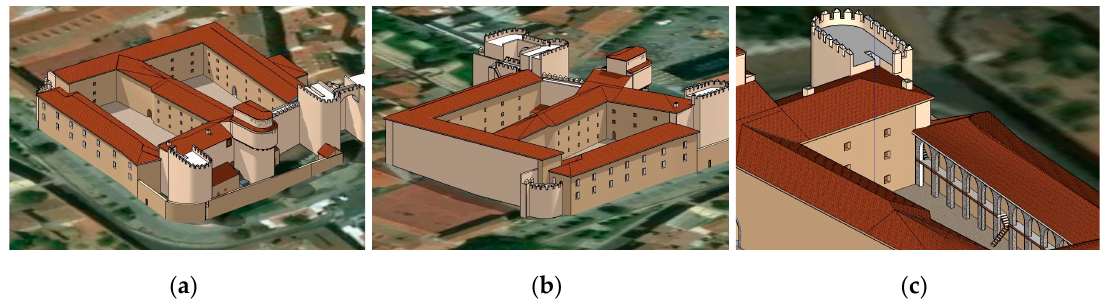
Figure 8. Intramural buildings: different views of the Alcázar after 1750: ( a ) southeast view; ( b ) southwest view; ( c ) detail of the officer’s gallery from Northwest viewpoint. [1].